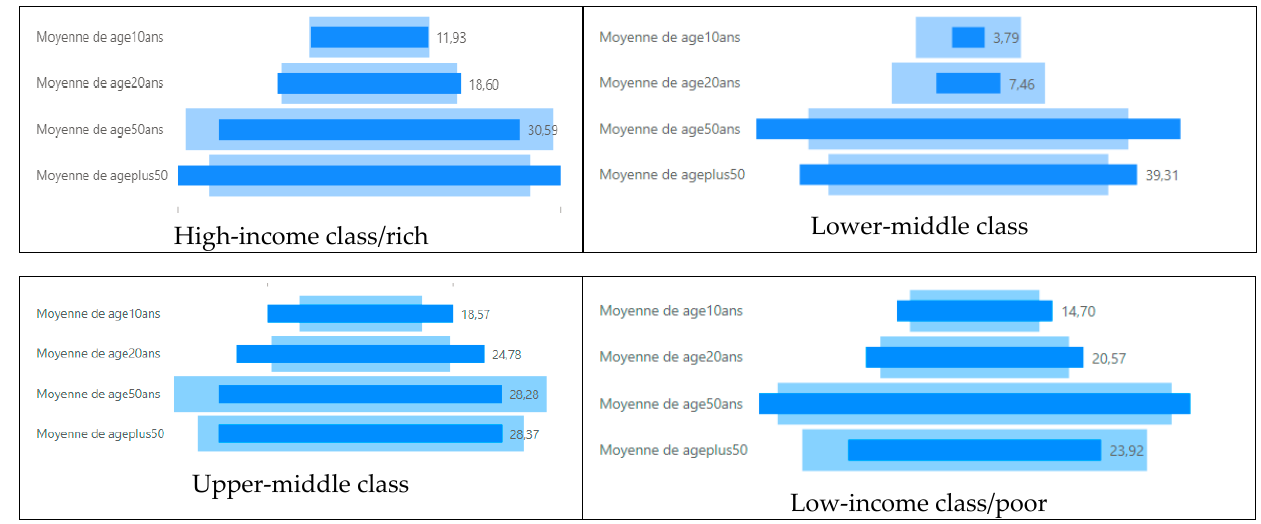
Figure 13. Dwelling age by social class.